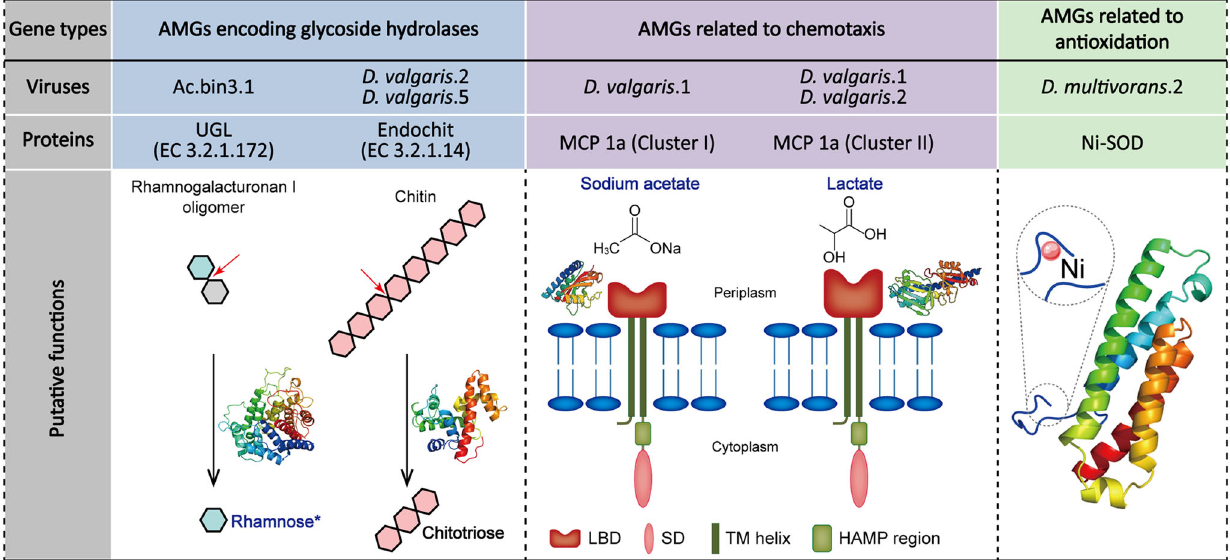
Fig. 4 Putative functions of proteins encoded by auxiliary metabolic genes (AMGs) of viruses infecting SRMs. UGL D-4,5-unsaturated β -glucuronyl hydrolase, Endochit endochitinase, MCP methyl-accepting chemotaxis protein, Ni-SOD nickel-containing superoxide dismutase, LBD ligand-binding domain, SD signaling domain, TM transmembrane, HAMP histidine kinase, adenyl cyclase, methyl-accepting chemotaxis protein and phosphatase. Representative substrates of glycoside hydrolases (GHs) encoded by AMGs and the associated simplest products are shown. The cleavage points of the substrates are indicated by red arrows. The computational protein models of GHs, MCPs and Ni-SOD are displayed. Representative ligands of MCPs and the active site of Ni-SOD are shown. *, if the products of GHs or representative ligands of MCPs can be utilized directly by SRMs to reduce sulfate, their names are in blue. Additional details are presented in Supplementary Tables 10 and